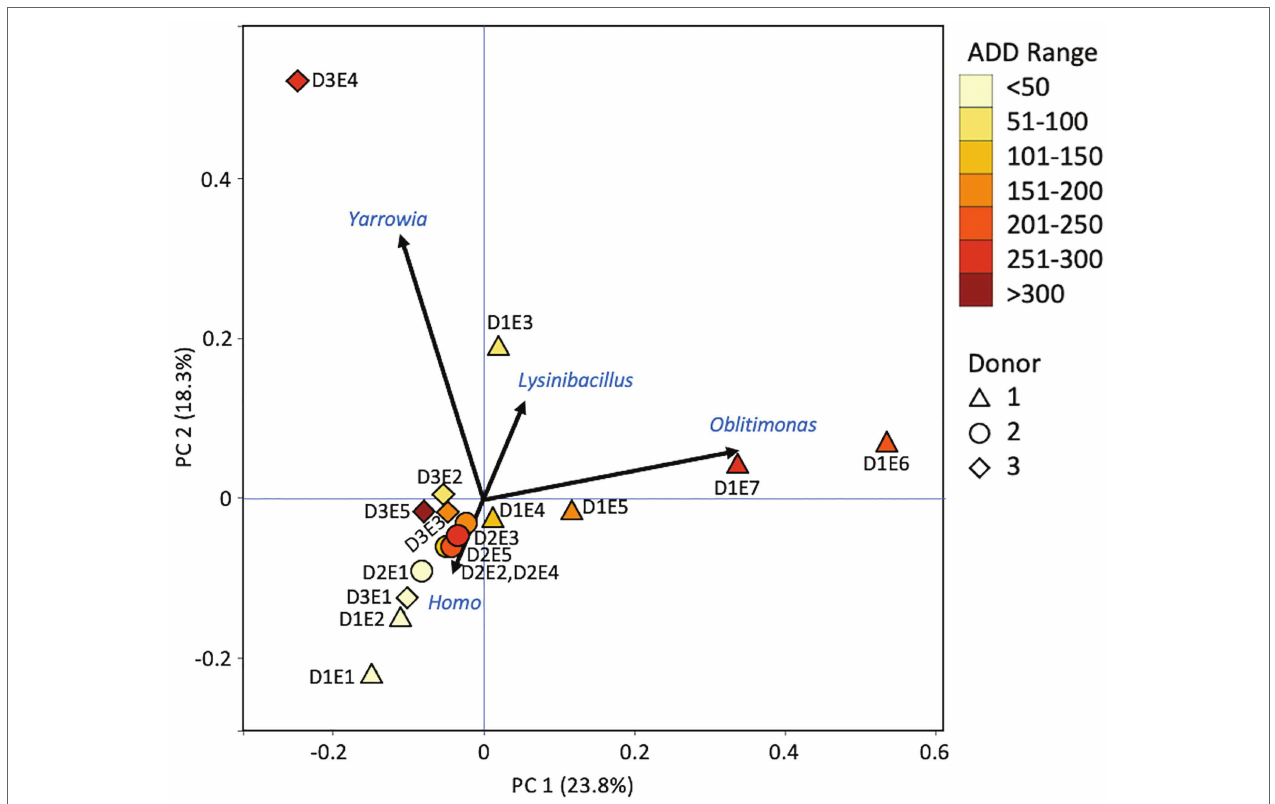
FIGURE 9 | Principal components analysis plot for the proportional data of bacterial and eukaryotic genera observed from shotgun MetaG sequencing from oral samples of three human donors (Donors 1, 2, and 3) during decomposition. Shading is added to the symbols [triangles for Donor 1 (D1), circles for Donor 2 (D2), and diamonds for Donor 3 (D3)] to show earlier (lighter shading) to later (darker shading) ADD and also times sampled (from E1 to E7 for D1 and E1 to E5 for D2 and D3, indicating first sample to last sample